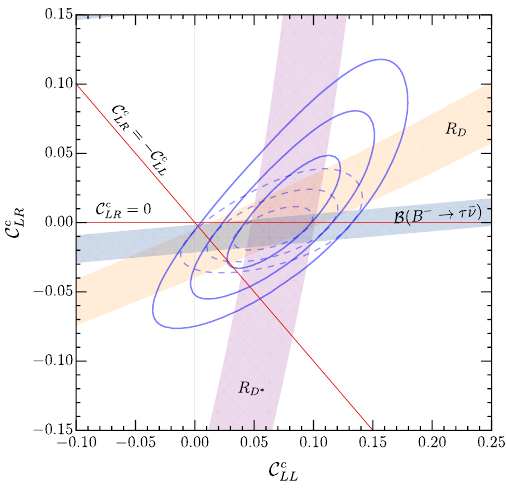
and R in the C c - C c plane (coefficients D D ∗ LL LR = C c , LL LL